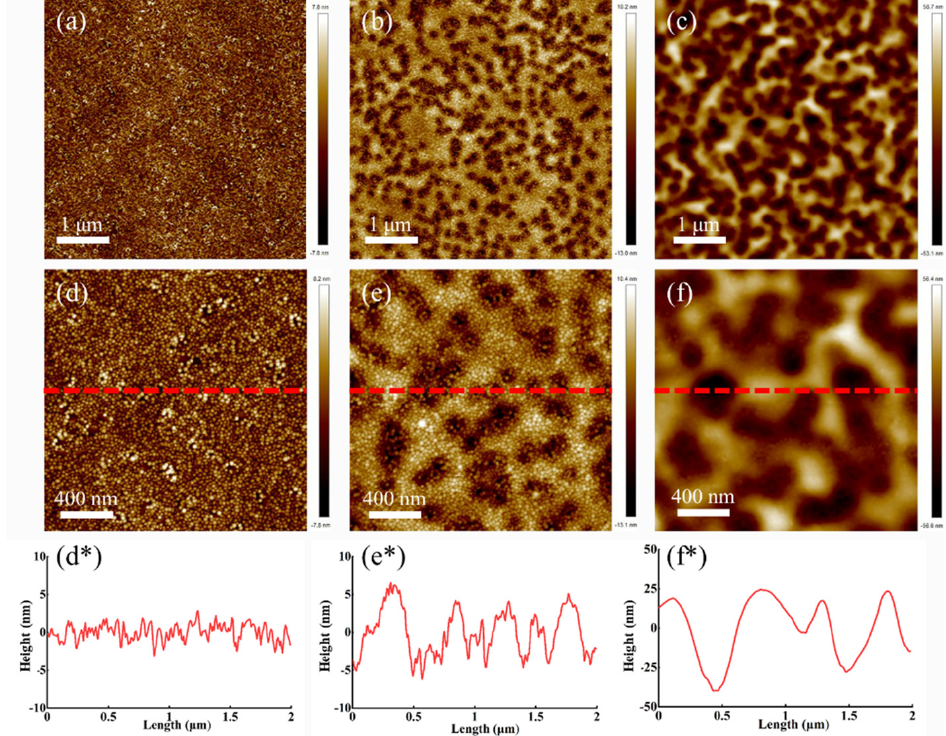
Table 1. Surface roughness of N–A TiAl fi lm with various 20 keV helium implantation fl uences. Rq is the root mean square